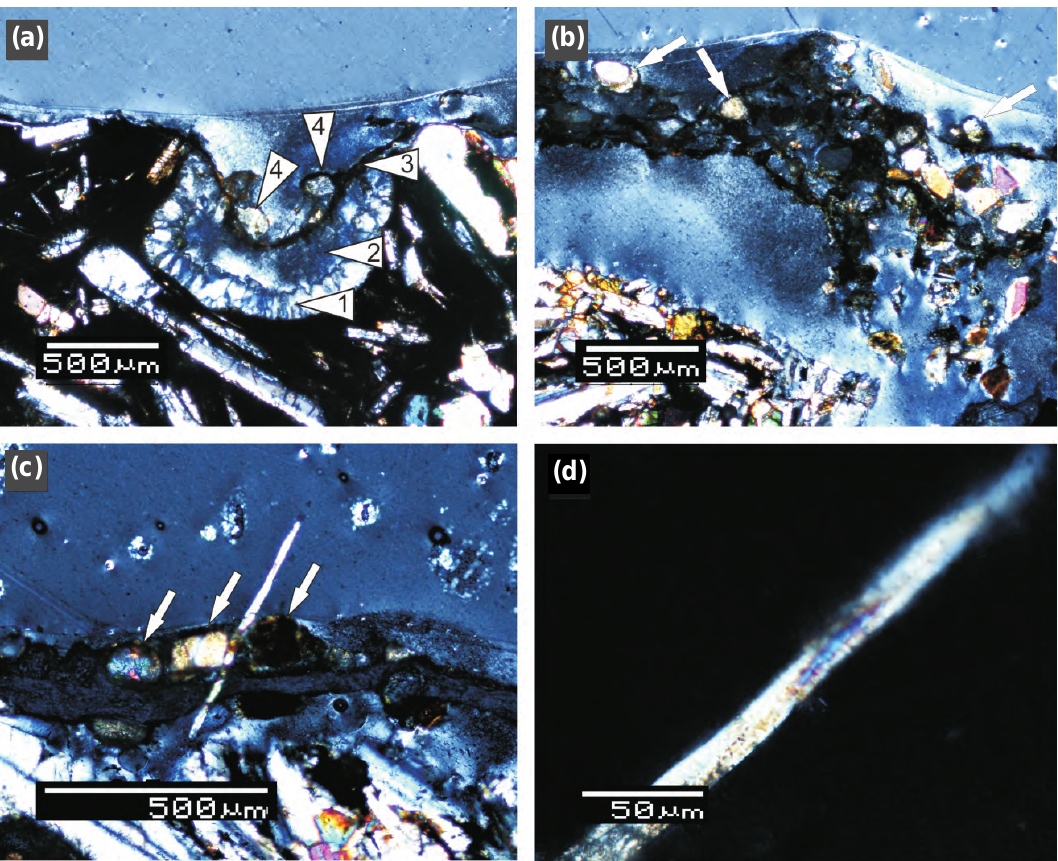
Figure 8. Perpendicular thin sections of rock substrate covered by dry biofilms (recorded under cross-polarised light. Note that biofilms are partly detached from the surface of the rock due to complete drying of the sample. (a) Conspicuous U-shaped empty void (arrowed “2”) near the surface of basaltic rock partly infilled with crystals of feldspathoids (tectosilicate minerals, arrowed “1”); empty void is bridged by biofilm (arrowed “3”) with partly incorporated mineral clasts, represented by semi-rounded quartz grains (arrowed “4”). (b) Rather thick biofilm with numerous incorporated mineral grains; note that close to the rock substrate the angular grains of plagioclase (feldspar group) and augite (pyroxene group) dominate, being derived from basaltoids, whereas close to the surface rounded grains of quartz occur (arrowed). (c) In situ calcium carbonate spicule penetrating biofilm and surrounded by incorporated grains of feldspars (two arrows on the left) and pyroxene (arrow on the right). (d) Close-up of the same calcium carbonate spicule with a possible cyanobacterial filament in its